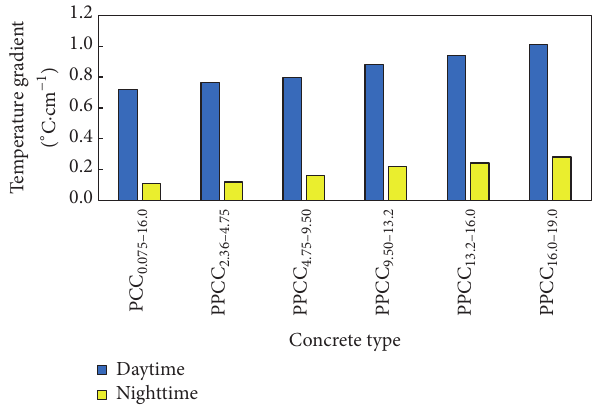
Figure 7: The temperature gradients of different